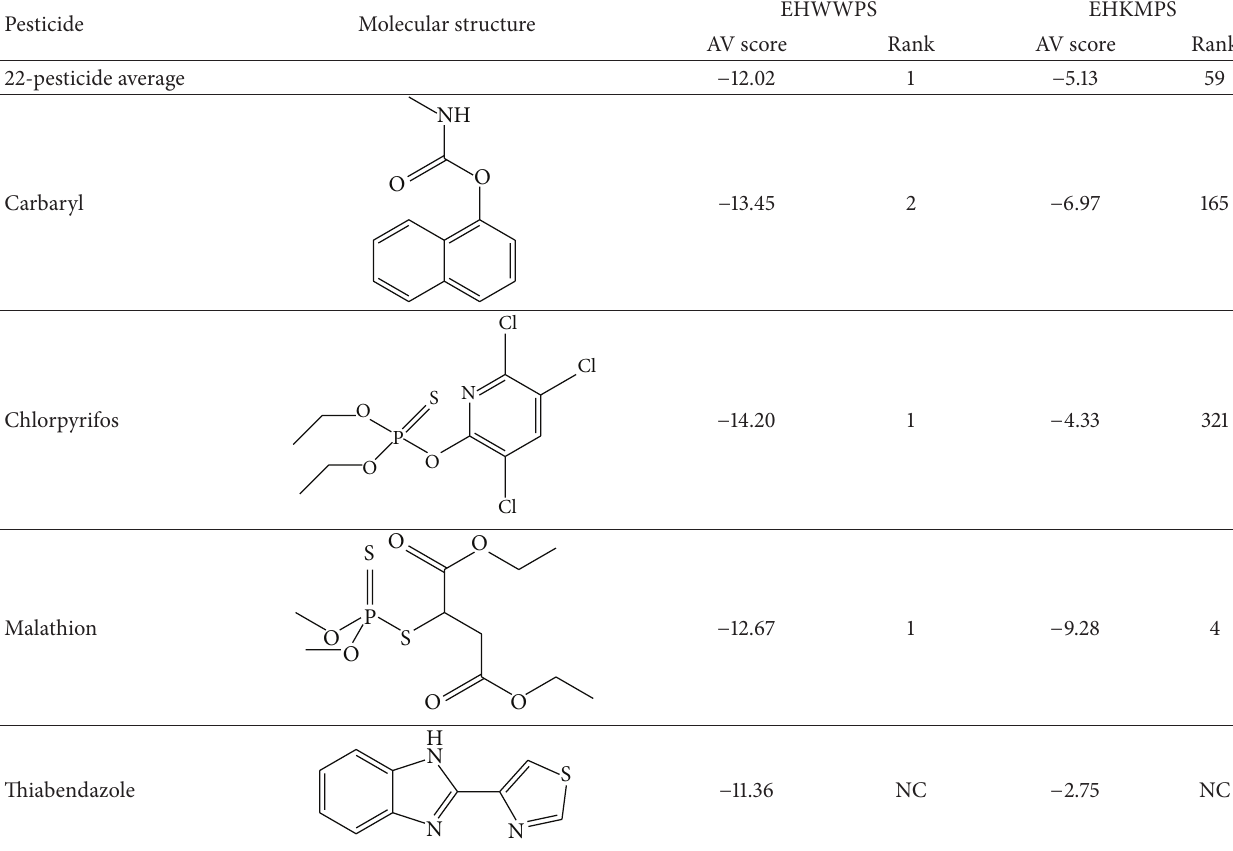
Table 1: The binding score and rank position in the 800 library docking runs obtained by the two hexapeptides versus analytes used in experimental SPE test. AV: average; NC: not calculated.